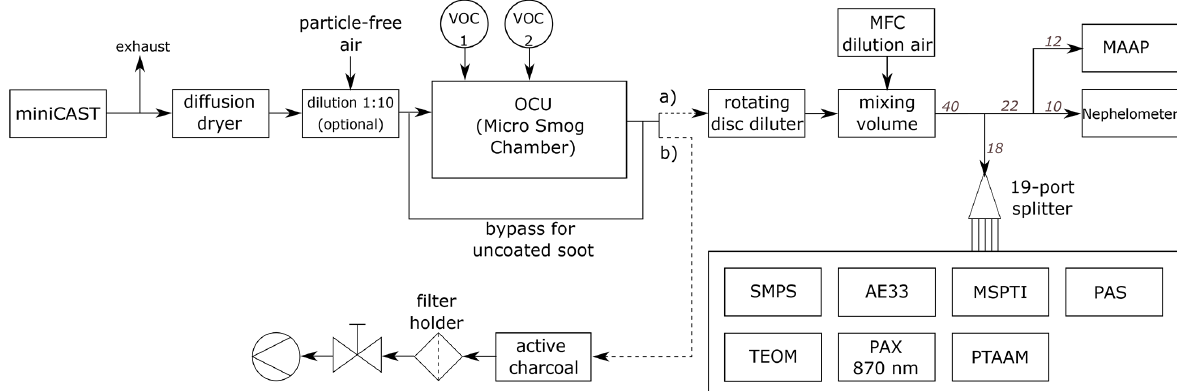
Figure 1. Schematic of experimental setup. The numbers above the arrows indicate aerosol flows in litres per minute (Lmin − 1 ).